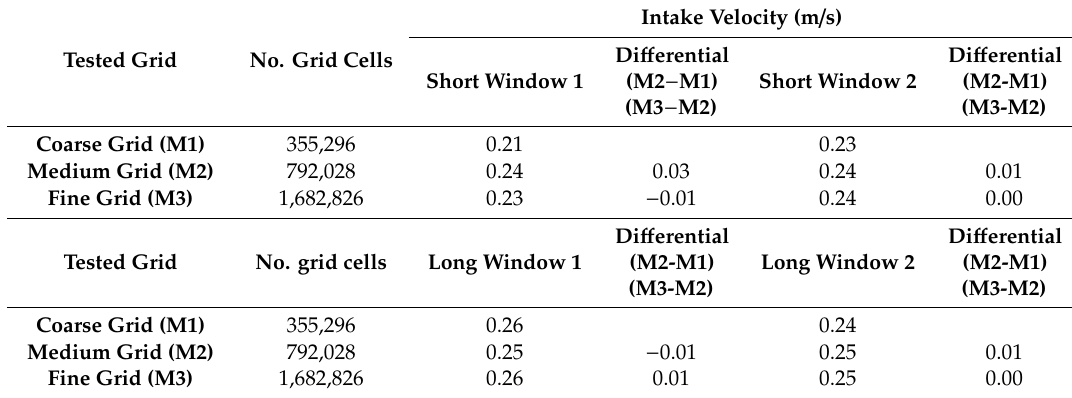
Table 2. Comparison of intake velocity for M1, M2, and M3 grids.